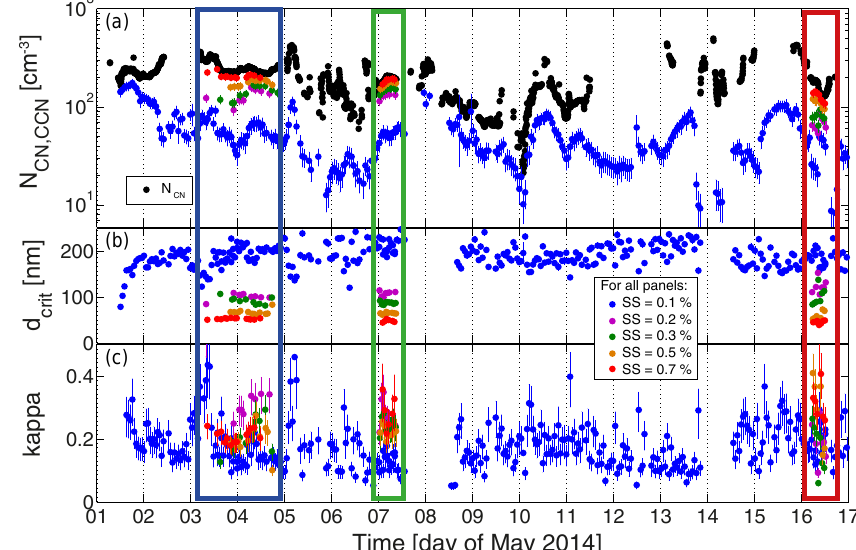
Figure 9. The time series of N CN and N CCN in panel (a) , d crit in panel (b) and the inferred κ values in panel (c) . The error bars of N CN and N CCN show the standard deviation whereas the error bars of d crit and κ show uncertainties that are determined by means of a Monte Carlo simulation. The blue data points show the unfiltered data corresponding to SS = 0.1%. The other colours correspond to the filtered data (SS ≥ 0.1%) of periods 1, 2 and 3, marked with the blue, green and red box,